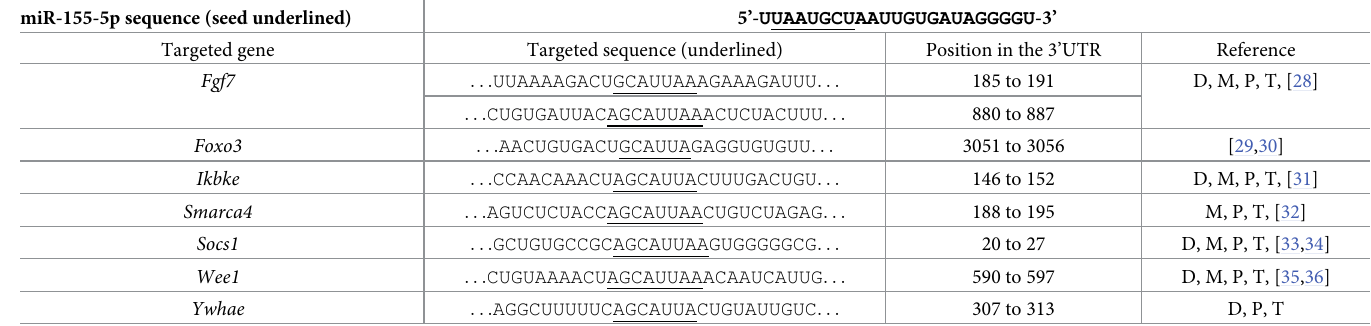
Table 2. Messenger RNAs targeted by miR-155 and the target sequences in the 3’UTR. D, M, P and T indicate the target RNAs found respectively with the DIANA-- TarBase v8 database, the miRDB, PicTar, and TargetScan softwares. Other references are cited in the reference column. miR-155-5p sequence (seed